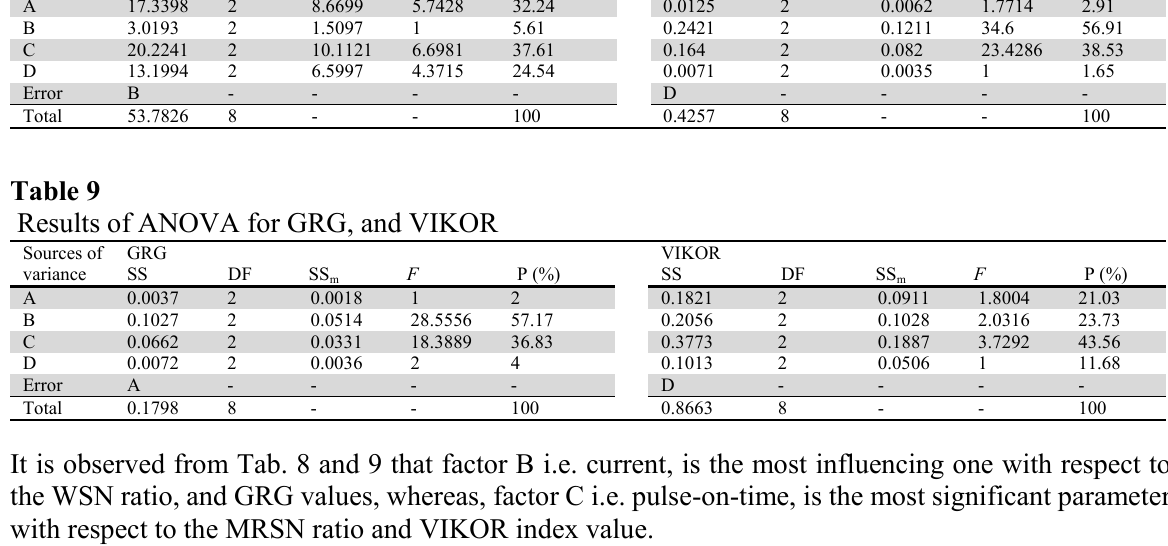
Results of ANOVA for MRSN, and WSN Sources of variance